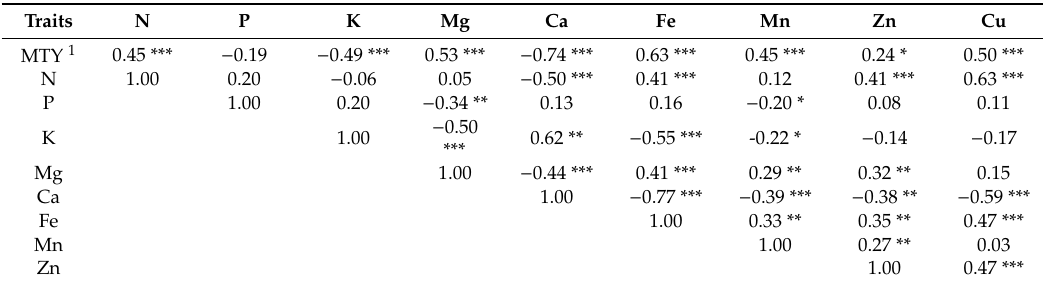
Table A6. Correlation matrix of relationships between nutrients in potato roots and stolons, and MTY ( n =